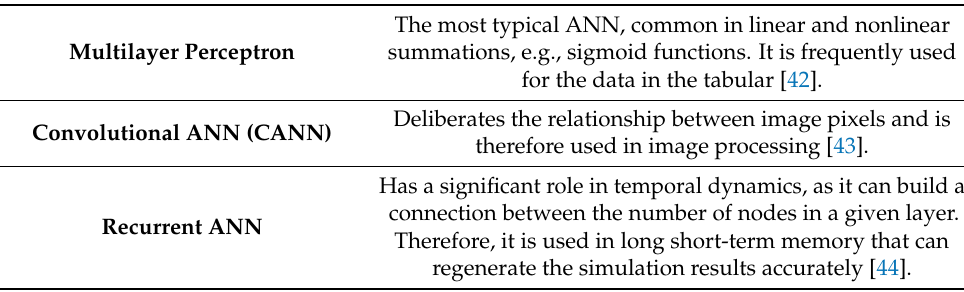
Table 2. Three classes of ANN